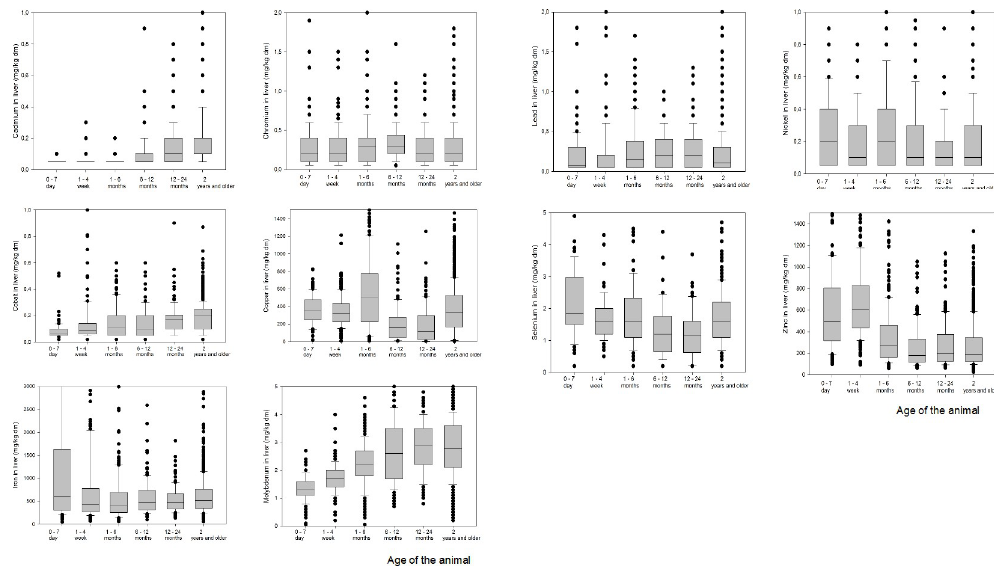
Fig 1. Box plots of elements for each age group. Fig 1A Cadmium, Fig 1B Chromium, Fig 1C Cobalt, Fig 1D Copper, Fig 1E Iron, Fig 1F Lead, Fig 1G Molybdenum, Fig 1H Nickel, Fig 1I Selenium, Fig 1J Zinc.